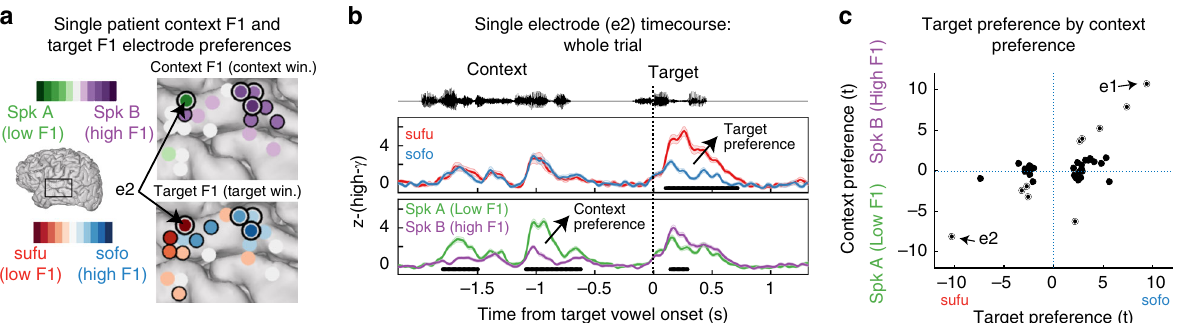
Fig. 3 Sensitivity to contrast in acoustic-phonetic features. a Electrode preferences for both context F1 (during context window) and target F1 (during target window) from a single example patient. Some populations display both target F1 selectivity and context F1 selectivity (marked with a black-and-white outline), indicating a general preference for higher or lower F1 frequency ranges. Others are only tuned for target F1 or context F1 (marked with a single black outline in their respective panels). Signi fi cance assessed at p < 0.05 uncorrected. b Mean (±1 s.e.m.) high-gamma activity at an example electrode (e2) from the example patient in panel a (conditions split as described in Fig. 2c). Activity is displayed for a time window encompassing the full trial duration (both precursor sentence and target word). Black bars represent signi fi cant time-clusters ( p < 0.05; cluster-based permutation). c A relation exists between the by-electrode context preference and target preference: electrodes that display a preference for either high- or low-target F1 typically also display a preference for the same F1 range during